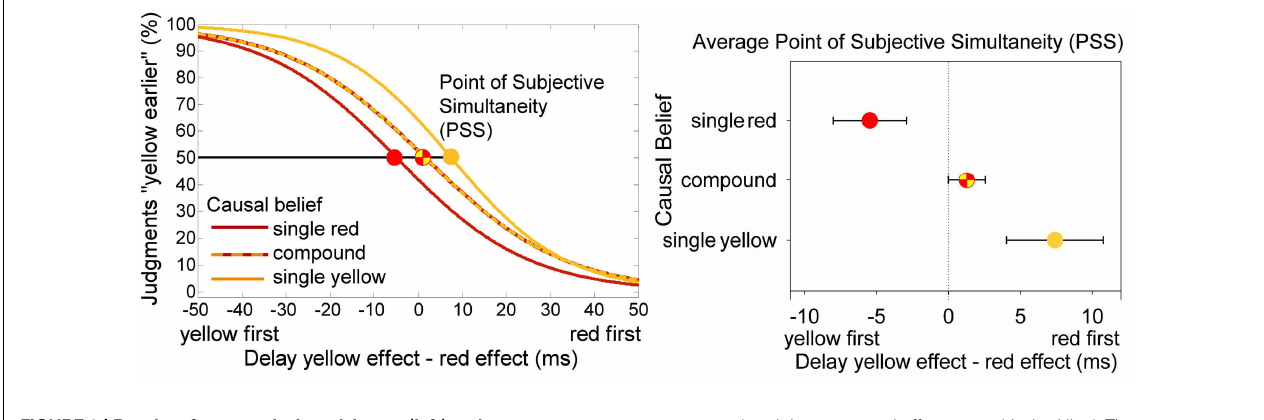
FIGURE 3 | Results of prototypical participants (left) and group means for the PSS (right). On the left fitted functions of three prototypical participants from the single effect yellow and red group (colors according to